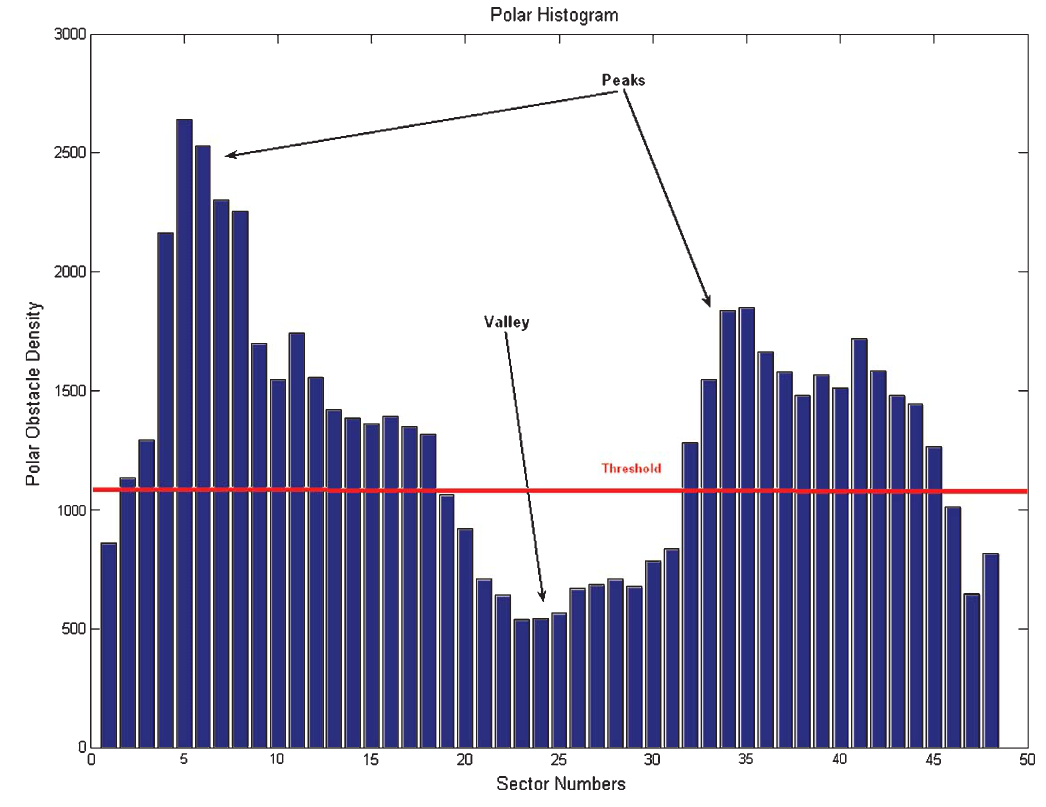
Fig. 6. The polar histogram and the valleys